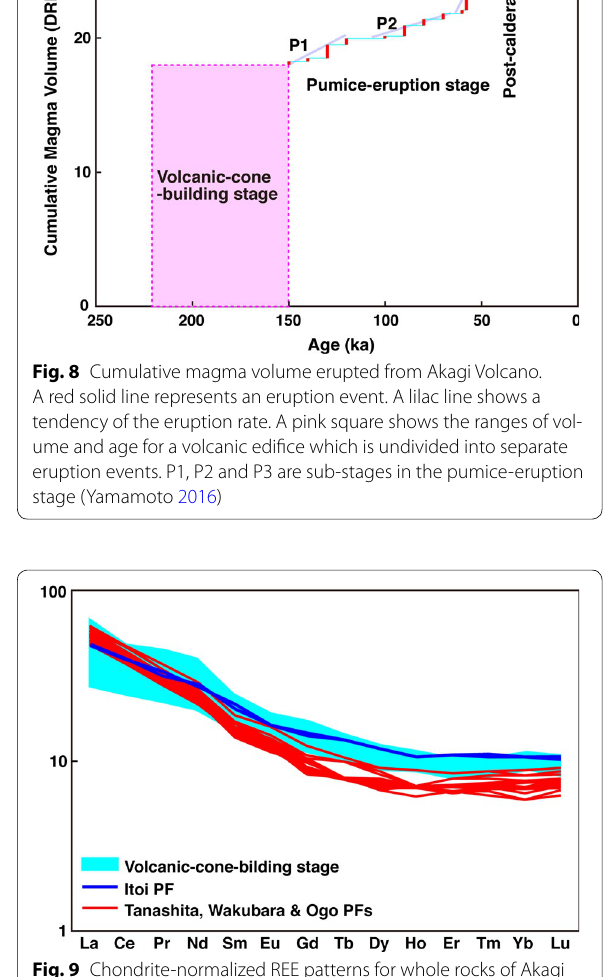
Fig. 9 Chondrite-normalized REE patterns for whole rocks of Akagi Volcano. The normalized values are from McDonough and Sun (1995). The hatched area shows the range of REE patterns for andesite lava flows in the volcanic cone-building stage (Kobayashi and Nakamura 2001). Other data are from Yamamoto (2016). The Itoi Pumice Flow (SiO 2 62.7–65.6 wt%) erupted at the end of the volcanic cone- = building stage (160 ka). The Tanashita, Wakubara, Ogo Pumice Flows (SiO 2 56.9–64.4 wt%) erupted during the pumice-eruption =